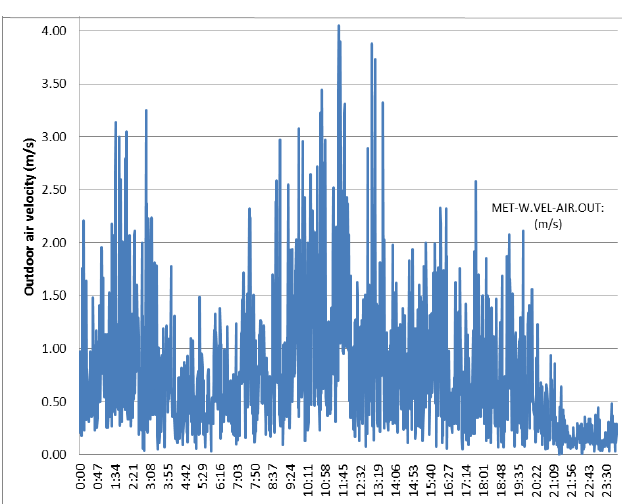
Fig. 12. Changes of outdoor wind velocity.